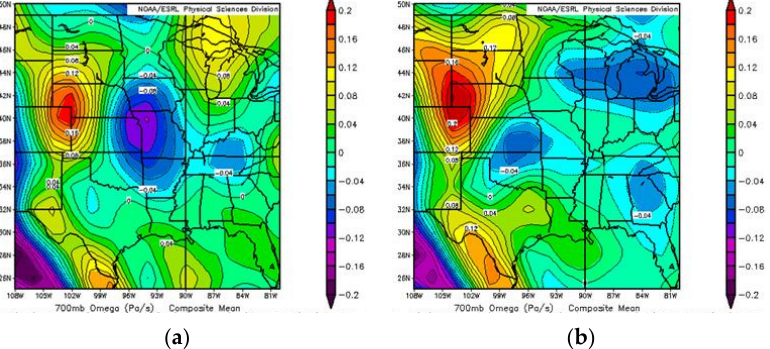
Figure 5. The 700-hPa vertical motion ( ω ) (Pa·s − 1 ) (shaded; every 0.02 Pa·s − 1 ) from − 0.2 to 0.2: ( a ) composites for elevated convection; and ( b ) composites for surface based convection.